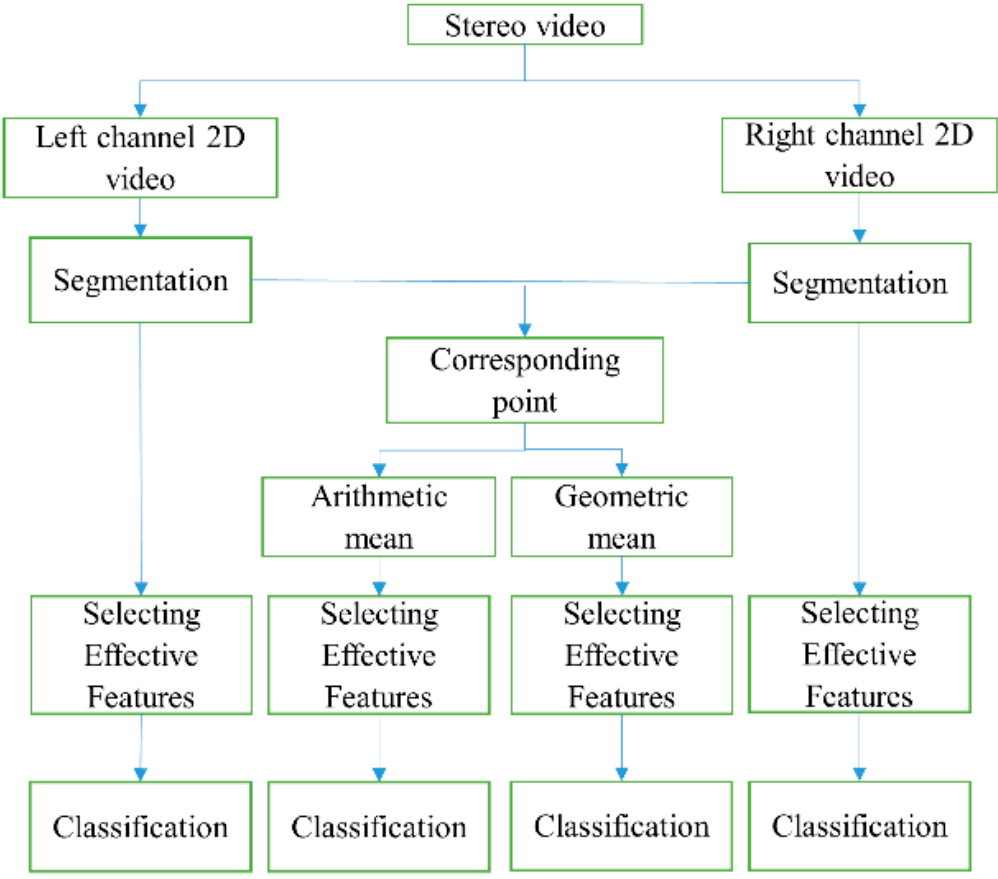
Figure 3. Flowchart of the proposed system for the classification of rice and weed plants inside rice fields by recording stereo video and decomposing the video into right and left channel data.